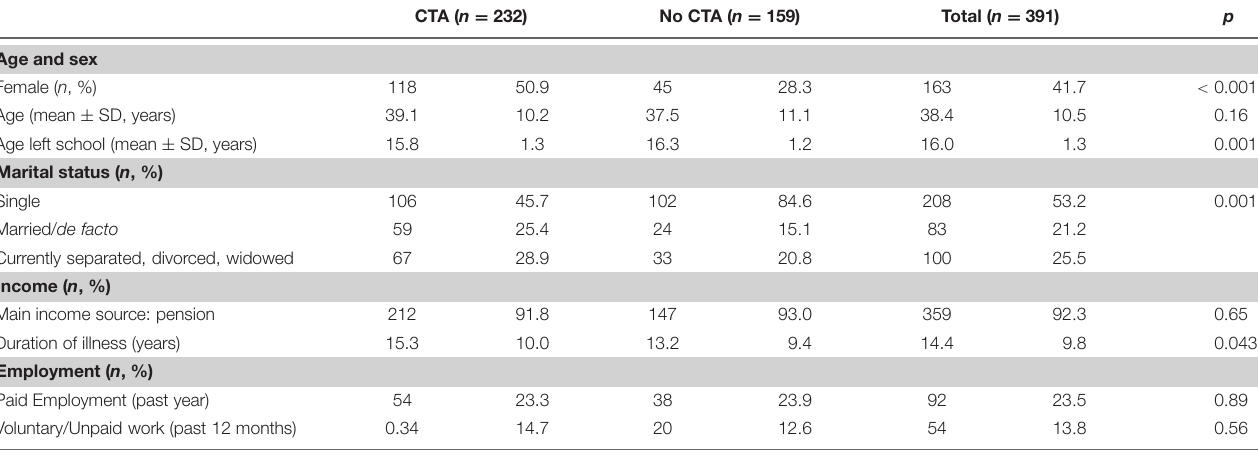
TABLE 1 | Socio-demographic data for people with psychosis, comparing those who had experienced childhood trauma and/or adversity (CTA) with those who had not. CTA ( n = 232) No CTA ( n = 159) Total ( n = 391) p